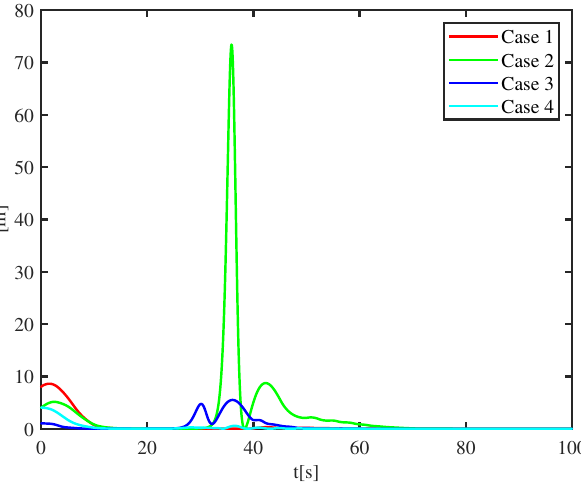
z 1 under four cases. Figure 4. z T 1